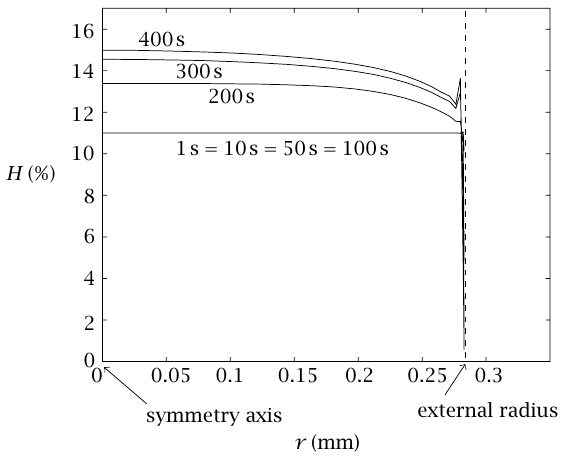
Figure 5.7 . Radial moisture content profile at z = 0.